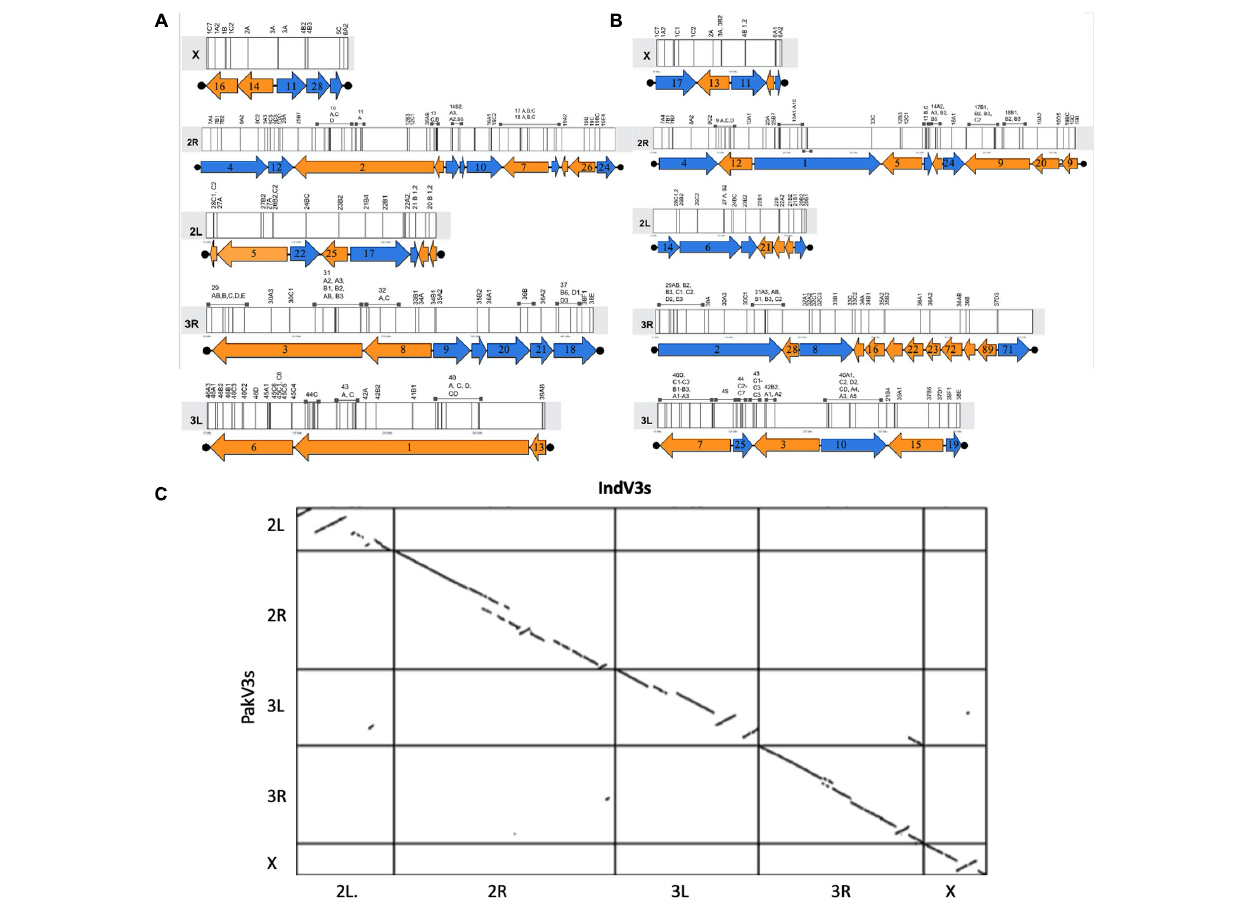
FIGURE 2 | Generation of pseudomolecules. (A,B) Karyogram showing placement of scaffolds from IndV3 (top-left) and PakV3 (top-right) assemblies used to stitch chromosome level assemblies, IndV3s and PakV3s, with DNA marker location on scaffolds. (C) Dot plot of IndV3s against PakV3s.